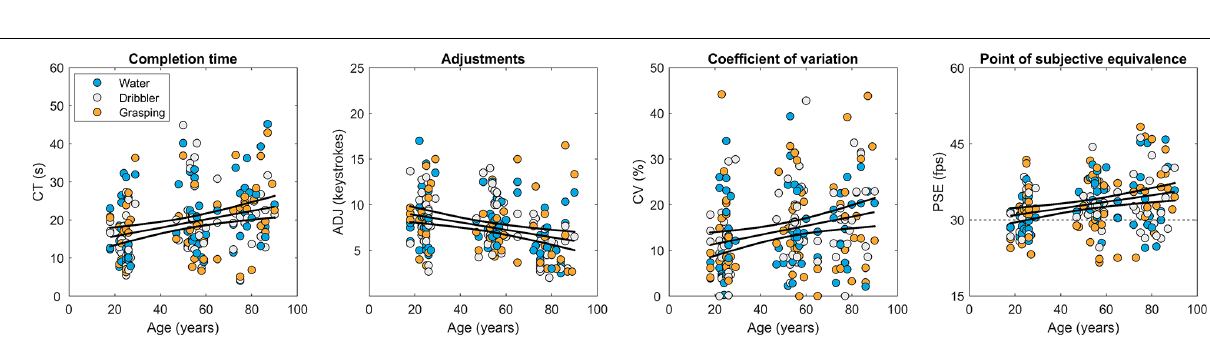
FIGURE 2 | Average adjustment traces in the three age groups. The final video speed tends to be higher than the original video speed, and this tendency was more marked for old adults and elders. The descending and ascending adjustment traces (when the initial video speed was higher or lower than the original video speed, respectively) did not fully converge, remaining always somewhat separated. In general, older participants tended to be slower in adjusting video speed. A 15-points smoothing was applied. The gray region represents the instantaneous 95% confidence band.